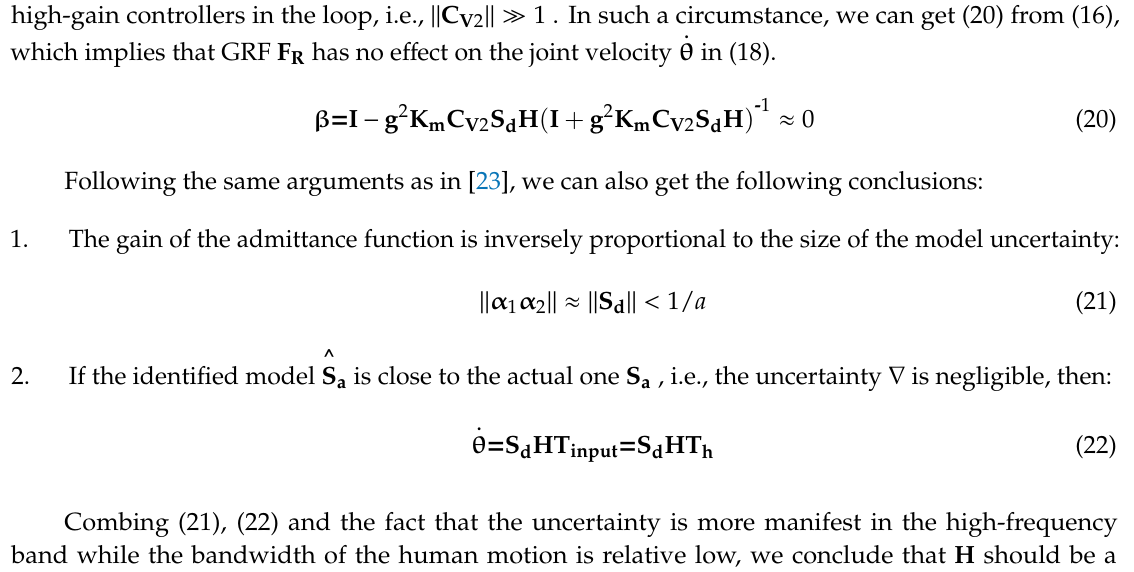
Figure 4. Block diagram of the single-leg exoskeleton control system; ( a ) integrated dynamics including motors, drivers and the exoskeleton mechanism; ( b ) ground reaction force (GRF) compensator; ( c ) admittance law; and ( d ) disturbance observer.